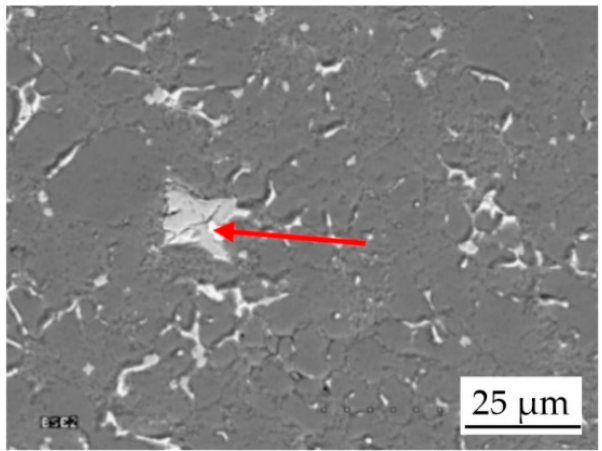
Figure 15. Microstructure of the HPDC Al-Si alloy containing approximately 0.25 wt % Cr, Mo, V, and W each with a marked example of the tested phase. Table 5. The chemical composition of ten randomly selected phases. Concentration, wt % Phase No.